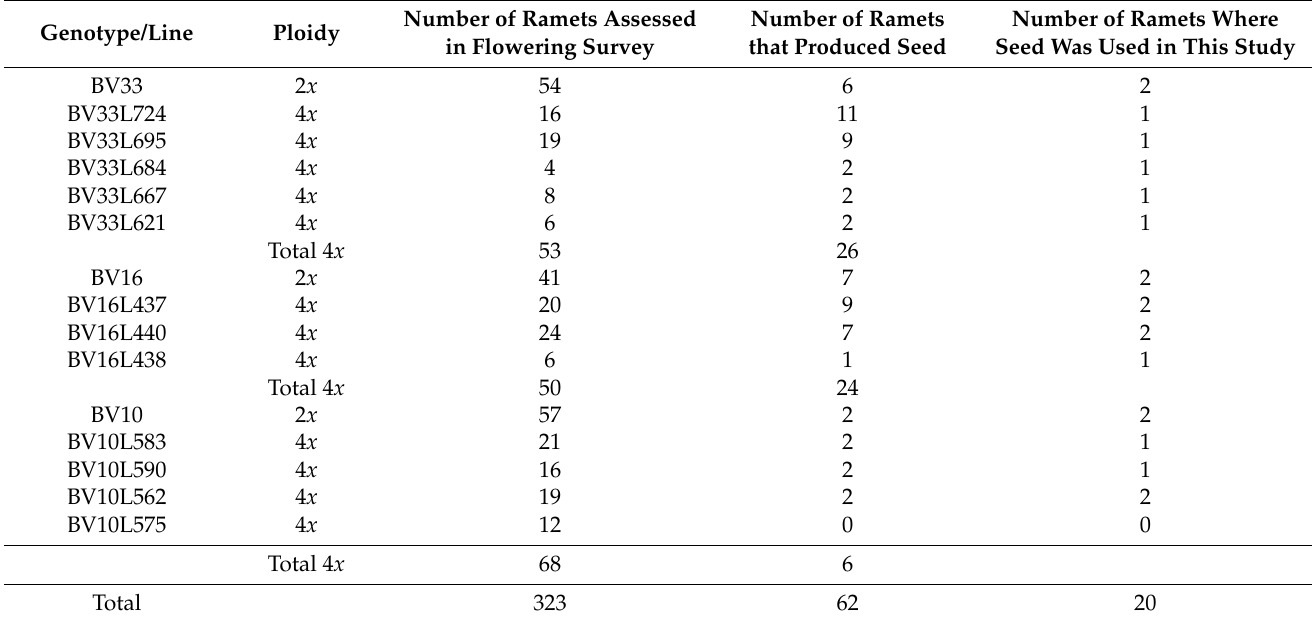
Table 1. Total number of ramets of diploid (2 x ) and allotetraploid (4 x ) acacia hybrid of each genotype observed and used as parents in the main study in